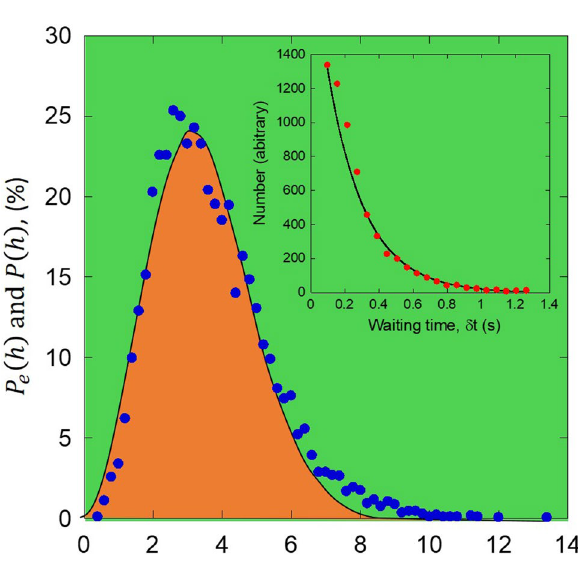
Figure 3. Normalized experimental distribution of serration sizes P e ( h ) (blue dots) compared with the Poisson distribution P ( h ) . Distribution of waiting time, δ t between successive serrations is shown in the